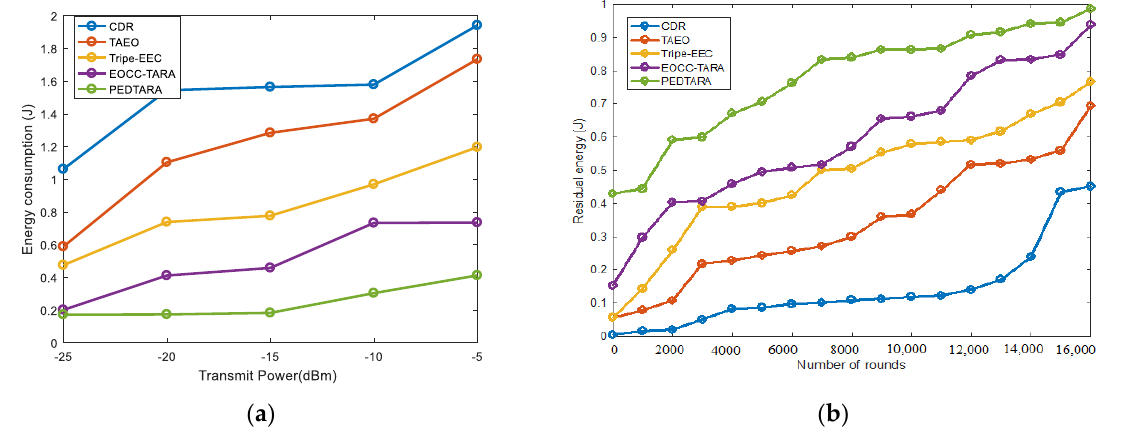
Figure 7. Energy consumption and residual energy comparisons: ( a ) energy consumption; ( b ) residual energy. Table 5. Energy consumption (J).